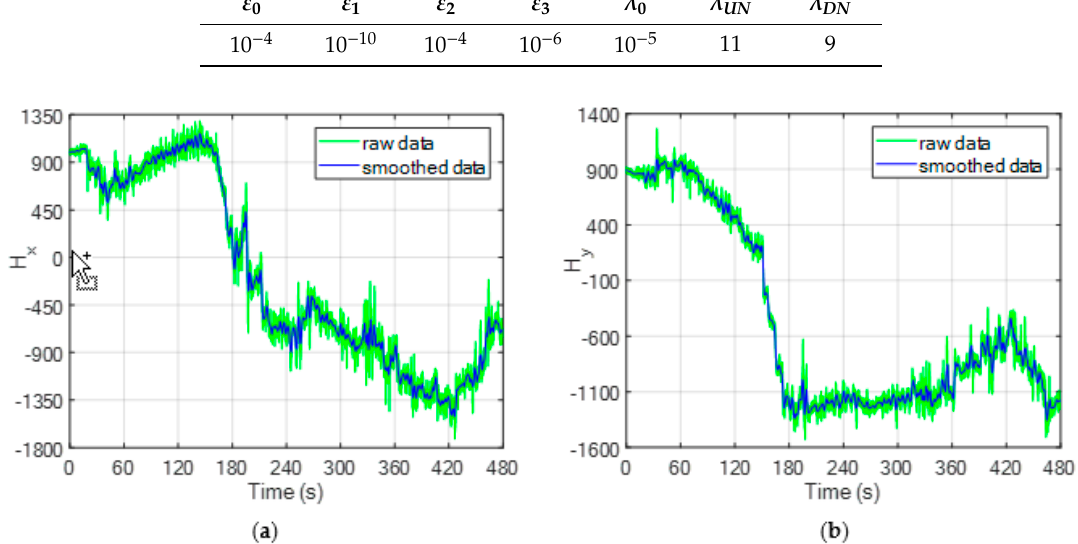
Figure 7. Time variation of the magnetometer measurements during the flight test. The raw data (green line) are smoothed using a moving average operator obtaining a lower-noise dataset (blue line). ( a ) Component of H along the x axis of BRF; ( b ) Component of H along the y axis of BRF. Please